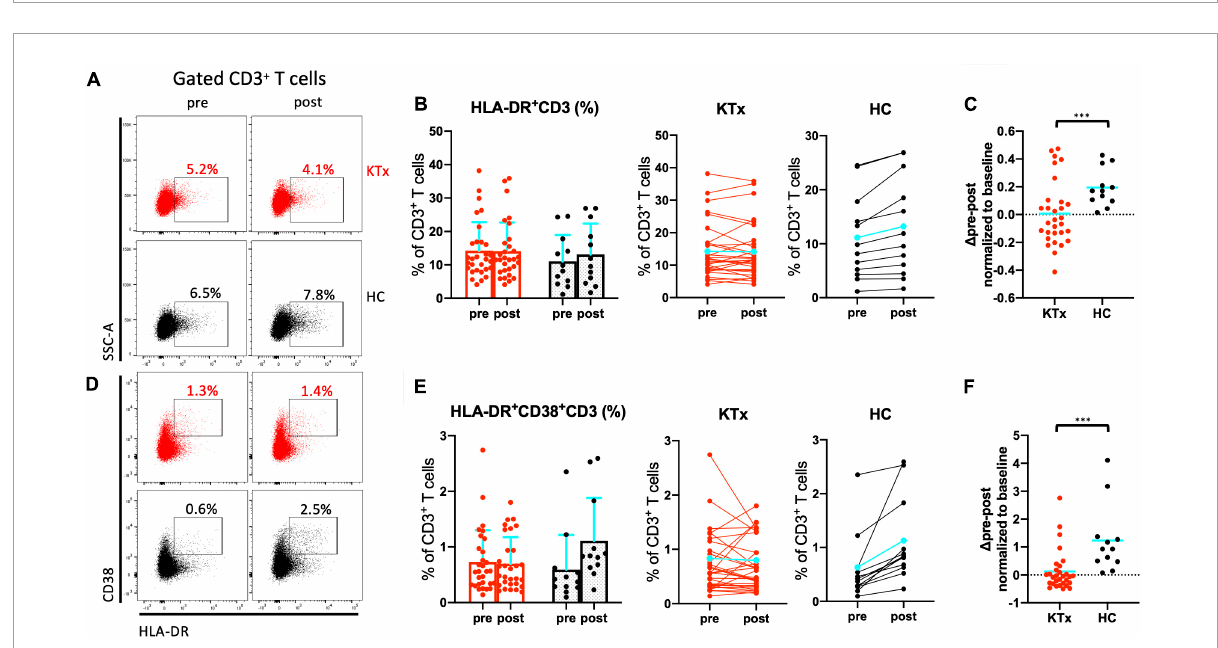
FIGURE3 Activated CD3 + T cells increased after SARS-CoV-2 mRNA vaccination in HCs not but KTx recipients. Representative gating strategies and scatter plots of activated HLA-DR + and/or CD38 + cells among CD3 + T cells in the two groups pre- and post-vaccination (A,D) . Comparison of the proportions and change in proportions of HLA-DR + (B) and HLA-DR + CD38 + (E) CD3 + T cells in KTx recipients (left) and HCs (right) as measured by flow cytometry. Normalized increase in HLA-DR + (C) and HLA-DR + CD38 + (F) CD3 + cells between pre- and post-vaccination. Bar plots depict mean ± SD. Blue lines and bars represent means. Data were analyzed using the Mann-Whitney U test (*** P <